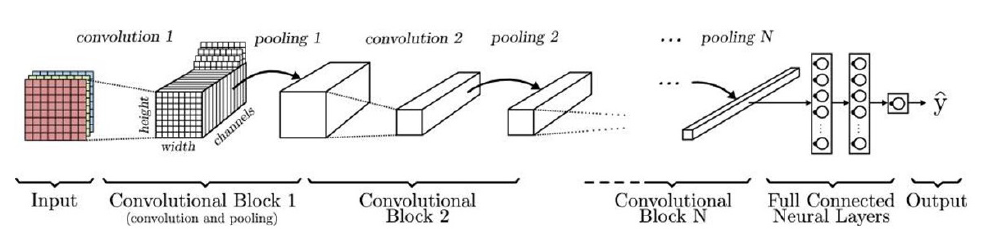
Figure 2. Architecture of convolutional neural networks